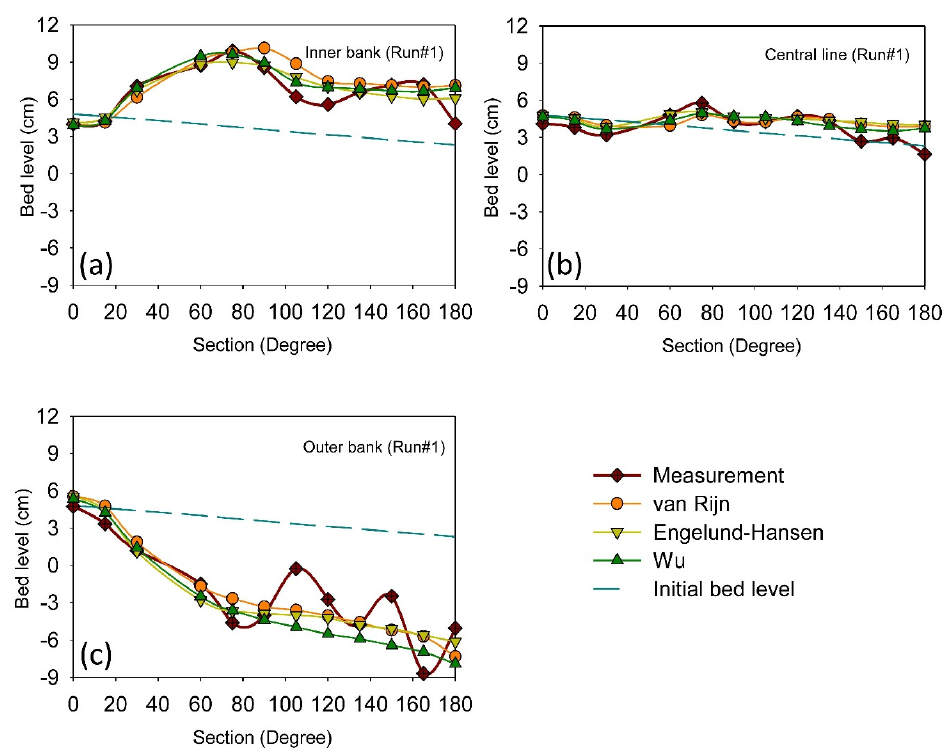
Figure 1. Initial and final bed levels of Run#1 along three longitudinal sections, ( a ) 10 cm from the inner bank, ( b ) the central line, and ( c ) 10 cm from the outer bank.